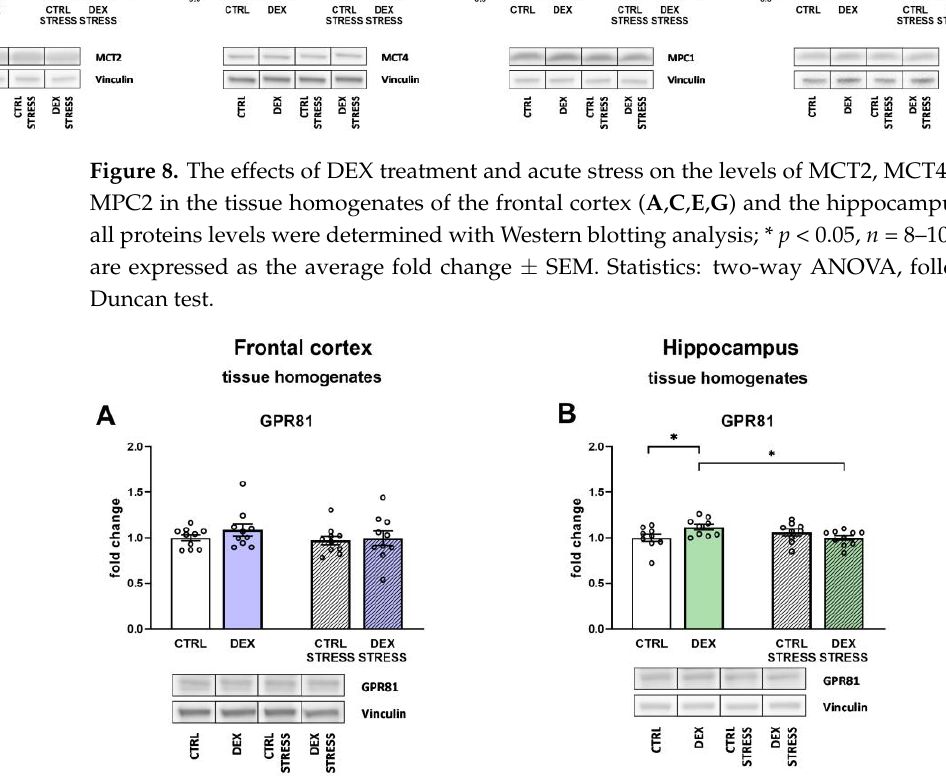
Figure 9. The effects of DEX treatment and acute stress on the level of GPR81 in tissue homogenates of the frontal cortex and ( A ) the hippocampus ( B ); protein level was determined with Western blotting analysis; * p < 0.05, n = 9–10. The results are expressed as the average fold change ± SEM. Statistics: two-way ANOVA, followed by the Duncan test.